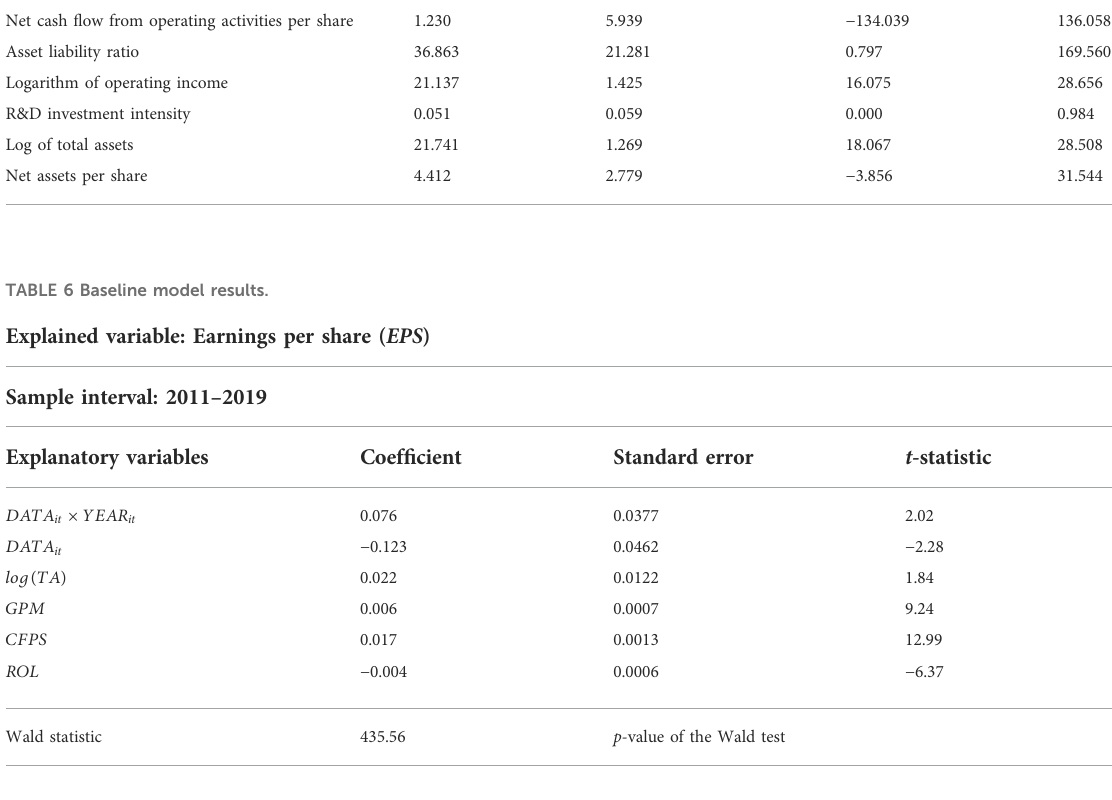
TABLE 7 Parallel trend test